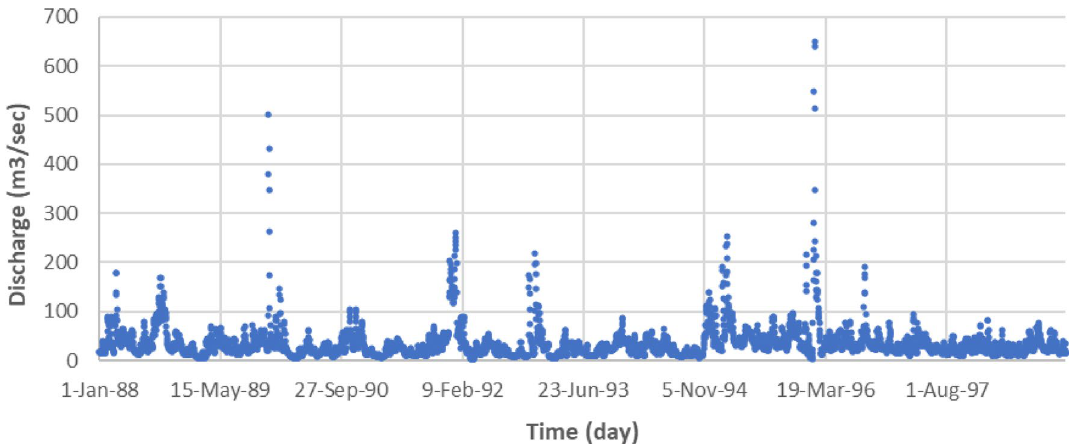
Figure 3. Discharge vs. time scatter plot for the Johor River basin from 1988 to 1998.